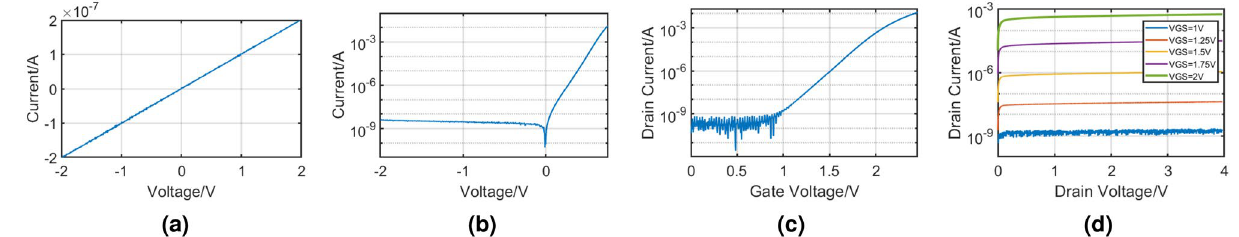
Figure 8. IV characteristics of a small selection of components. ( a ) IV sweep of a 10M (cid:31) resistor. ( b ) IV sweep of a 1N4148 diode, from − 2V to 0.75 V . c) Gate terminal and d) drain terminal sweeps of a 2N7000 nFET.